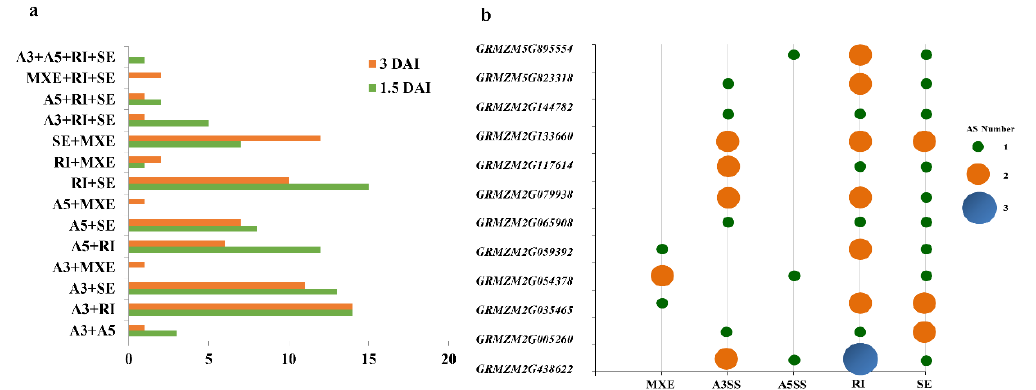
Figure 2. Comparison analysis of AS events in maize response to RBSDV. ( a ) Distribution of different AS modes of genes in maize infected with RBSDV at 1.5 and 3.0 DAI. ( b ) Genes with different AS events.